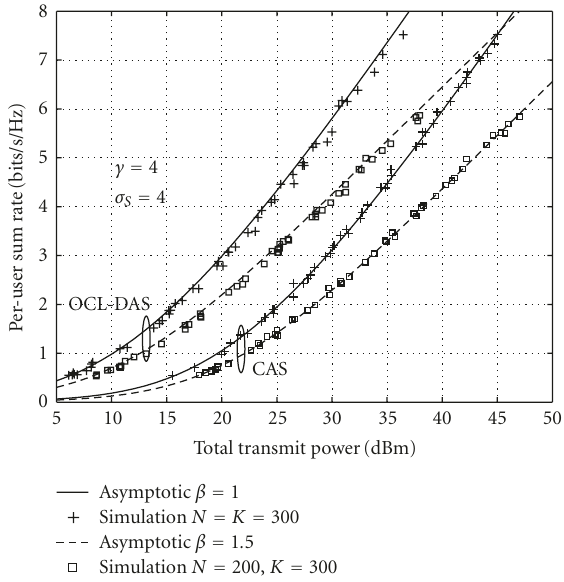
Figure 3: Simulation results for a large-scale system with γ =